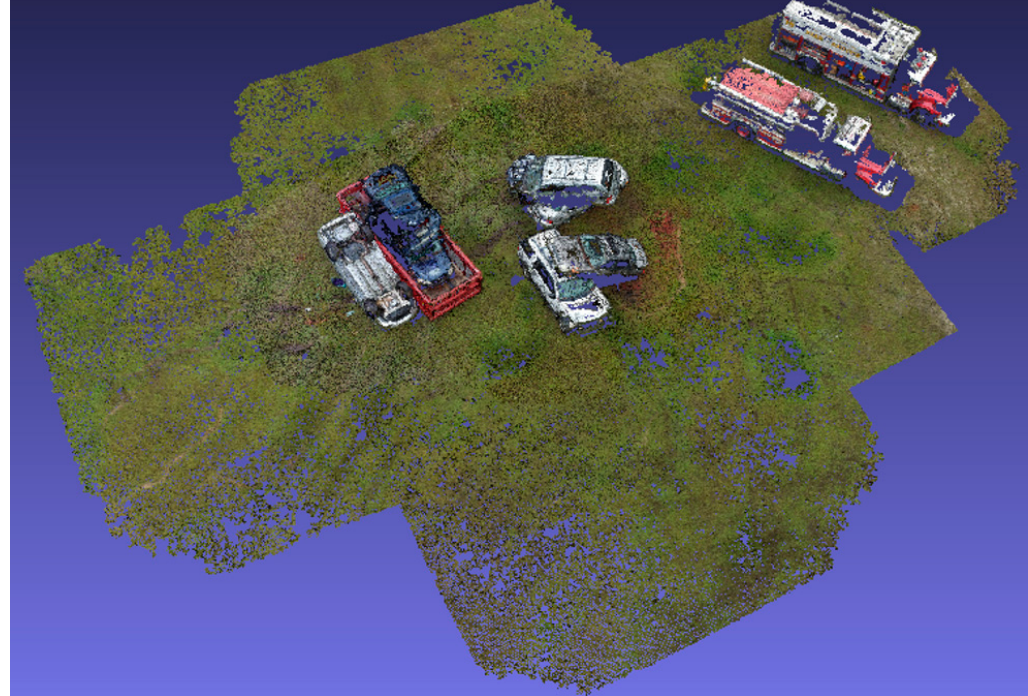
Figure 14. The sparse point-cloud model for the forensic dataset, and constructed by the ISFM system with the RTFT feature tracking method.